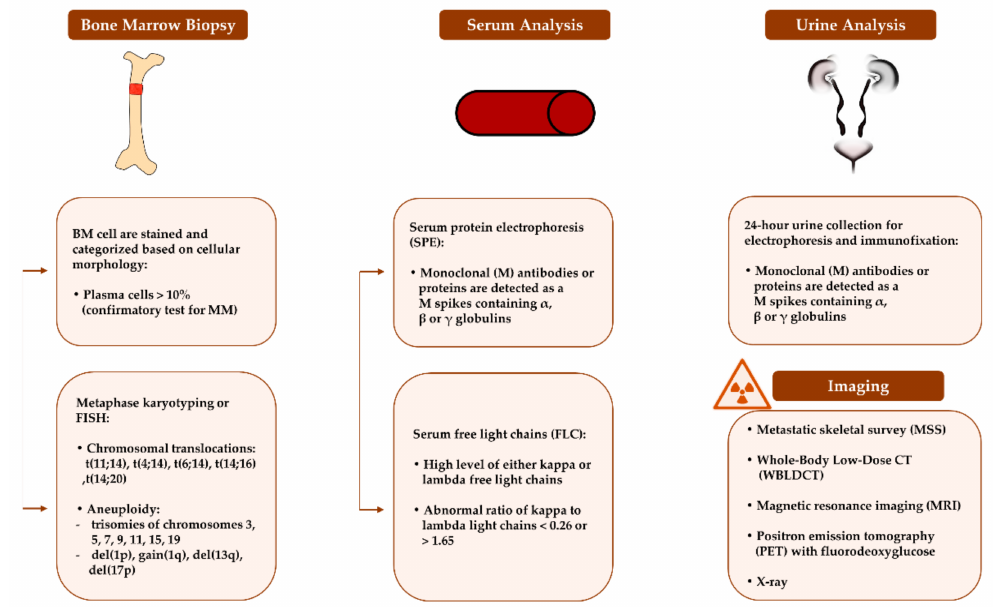
Figure 2. Biomarkers that are currently utilized for diagnosis and risk-stratifying of multiple